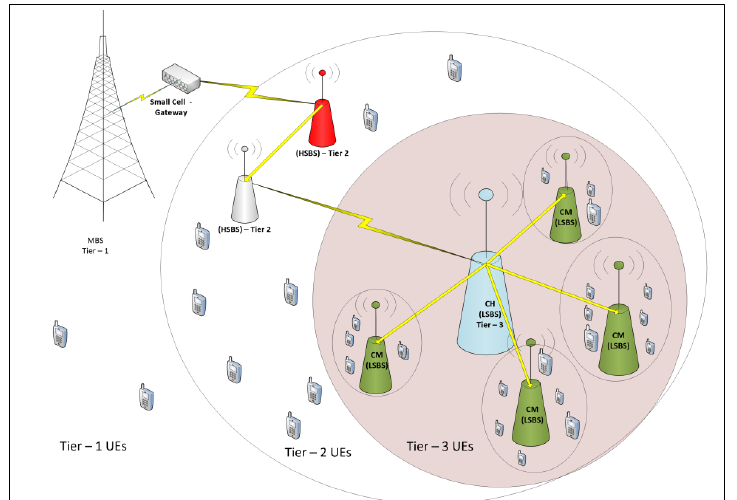
Figure 3. Power dissemination within the 3-tier HetNet.